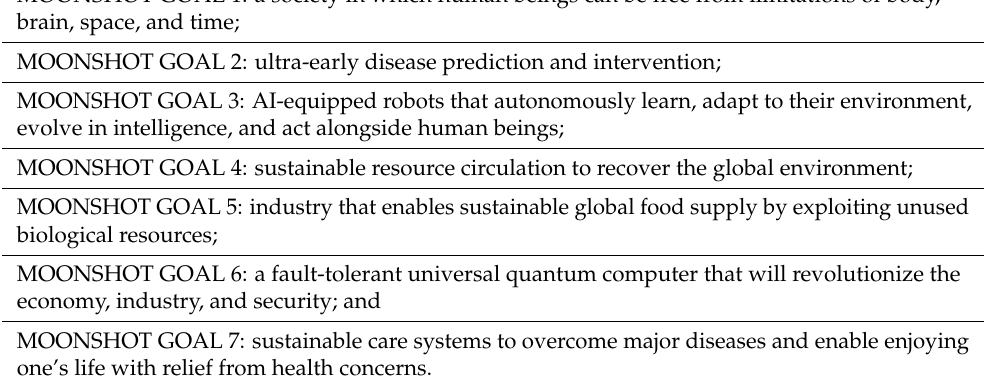
Table 2. Japan’s Moonshot